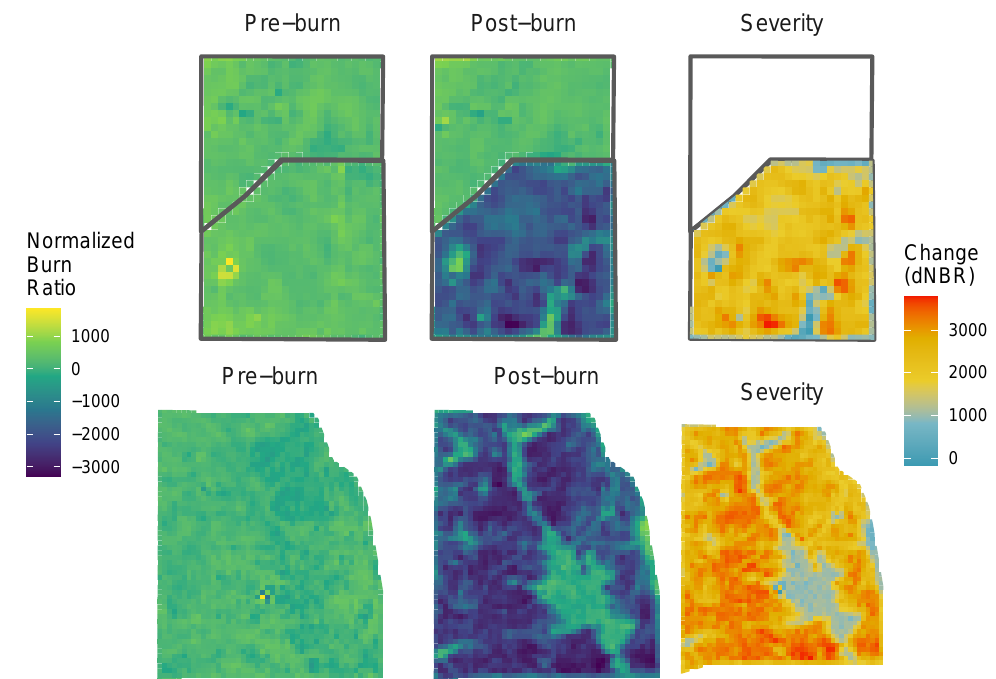
Figure 9. A comparison of remotely-sensed data products (LANDSAT 8) from before and after two burns at the Dunn Ranch Prairie. Pre-burn imagery was captured on 1 March 2022, and post-burn imagery was captured on 26 March 2022; fires were conducted on 15 and 16 March 2022 (top and bottom, respectively). The difference in the Normalized Burn Ratio (dNBR) provides a measure of burn severity across each unit (right-most images). Areas with “hotter” colors–increasing from yellow and orange to red–burned with greater severity, i.e., more above-ground plant biomass was